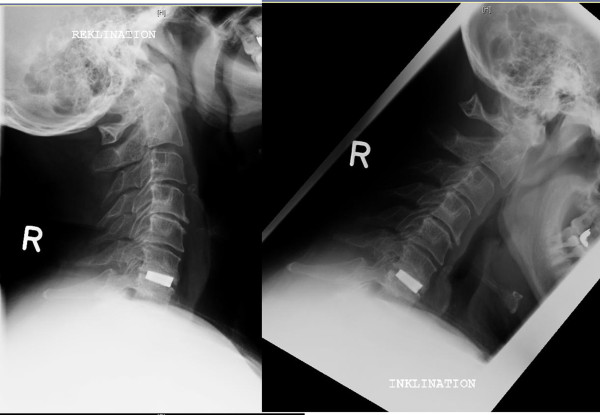
55-years old patient with a pseudarthrosis 3 years after surgery. The motion of the operated segment can be clearly seen by observing the movement of the spinous processes in the lateral functional x-rays.